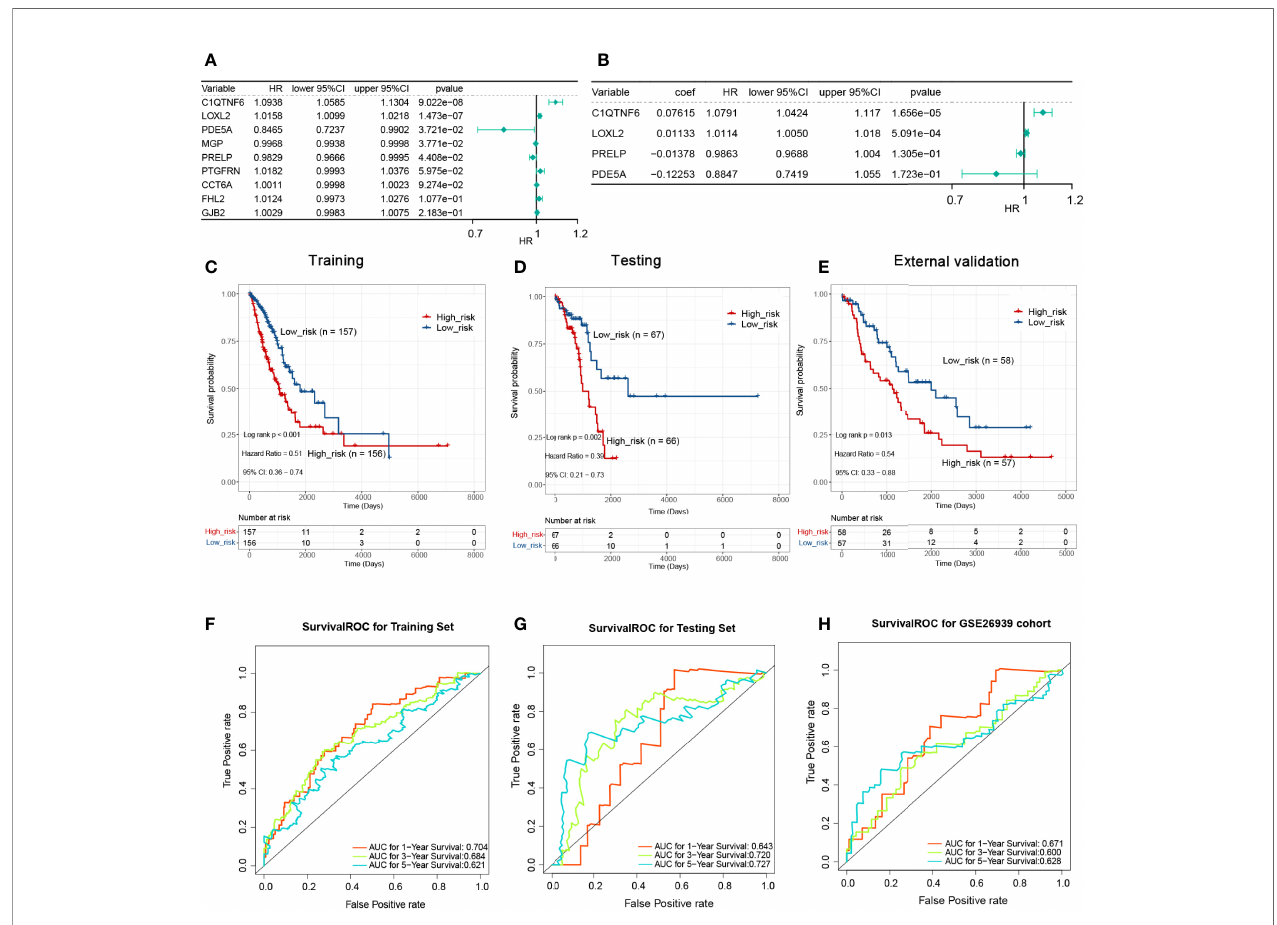
FIGURE 6 | Single-factor and multi-factor Cox regression analysis and construction of proportional hazards model (Cox model). (A) Single-factor Cox analysis of the forest map. Five genes with a signi fi cant impact on prognosis were determined. (B) Multivariate Cox analysis. A prognostic gene signature consisting of four POSTN - related-hub differentially expressed genes was established. (C) The Kaplan – Meier (KM) survival for the training set with high-/low-risk groups revealed that patients presenting with high-risk scores had a shorter survival time. (D) The KM survival for the testing set with a high-/low-risk groups revealed that patients presenting with high-risk scores had a shorter survival time. (E) The KM survival for the veri fi cation set with a high-/low-risk groups revealed that patients presenting with high-risk scores had a shorter survival time. (F) Survival receiver operating characteristic (ROC) for the training set for 1, 3, and 5 years for the risk-based prediction model. (G) Survival ROC for the testing set for 1, 3, and 5 years for the risk-based prediction model. (H) Survival ROC for the veri fi cation set for 1, 3, and 5 years for the risk-based prediction